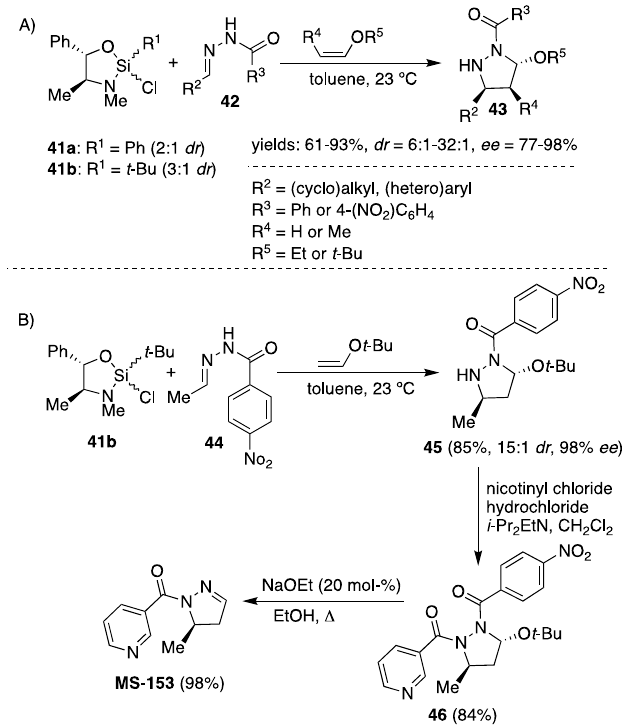
( B ) application of the methodology for the enantioselective synthesis of ( R )- MS-153